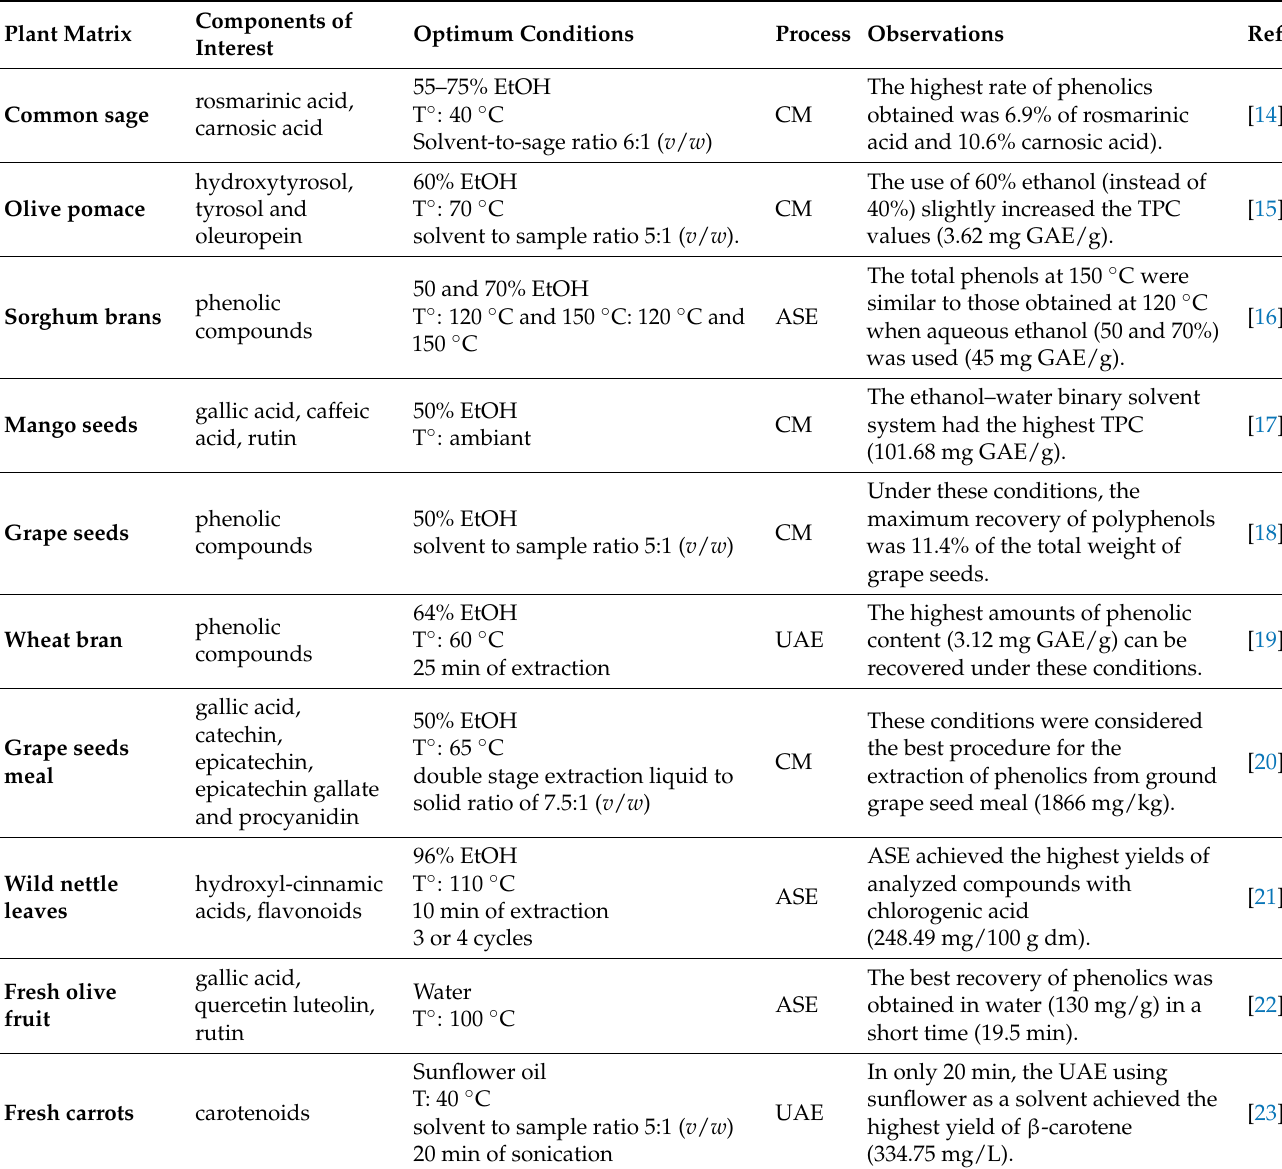
Table 1. Summary table of some articles using ethanol/water as extraction